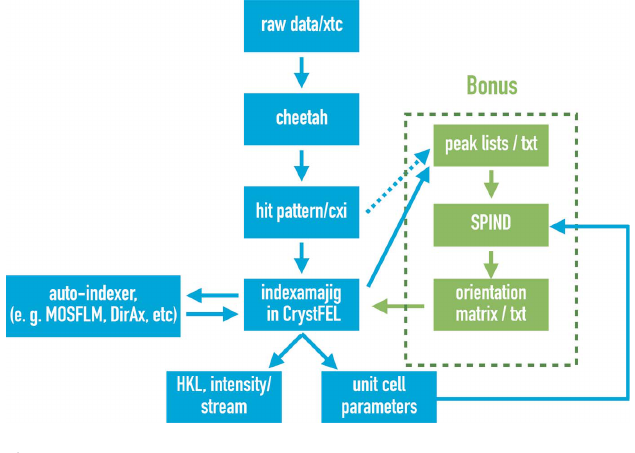
Figure 11 Schematic SFX data-analysis pipeline integrating SPIND to CrystFEL